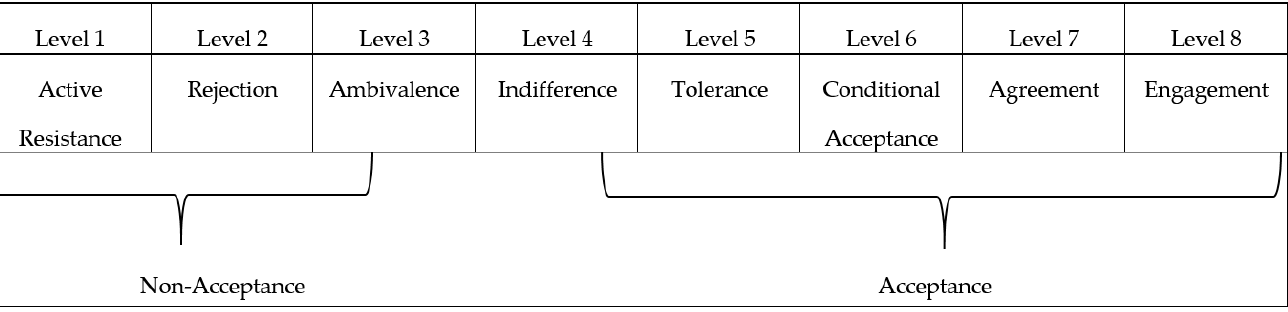
Figure 1. Acceptance levels based on Sauer et al. [16].